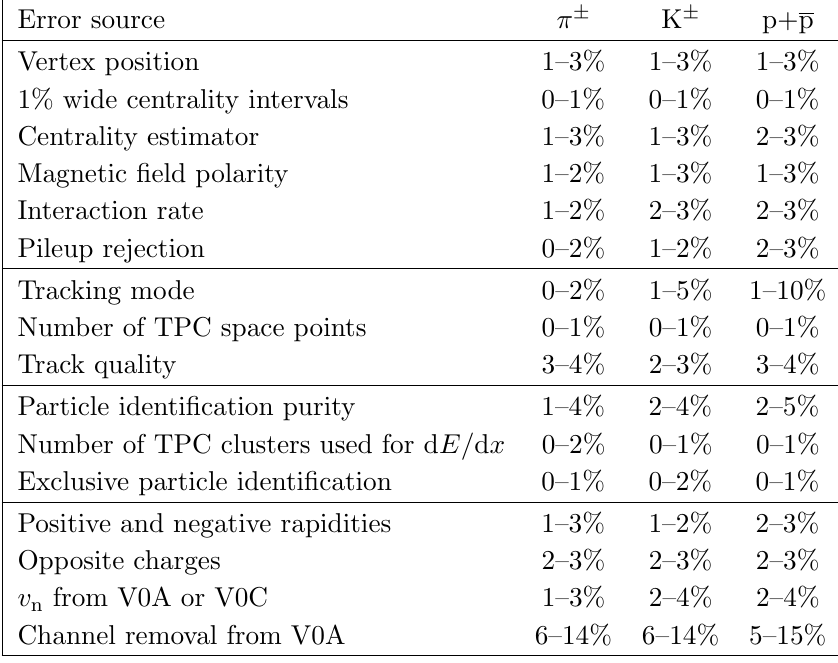
Table 3 . Summary of systematic uncertainties for the v 4 of (cid:25) (cid:6) , K (cid:6) , and p+p. The uncertainties depend on p T and centrality range; minimum and maximum values are listed here. Horizontal lines are used to separate the di(cid:11)erent categories of systematic uncertainties as explained in section 3. and 0.3 cm; (vii) varying the number of clusters in the TPC that are used to estimate the d E= d x of the V 0 daughter tracks from 70 to 60 and 90; (viii) varying the particle